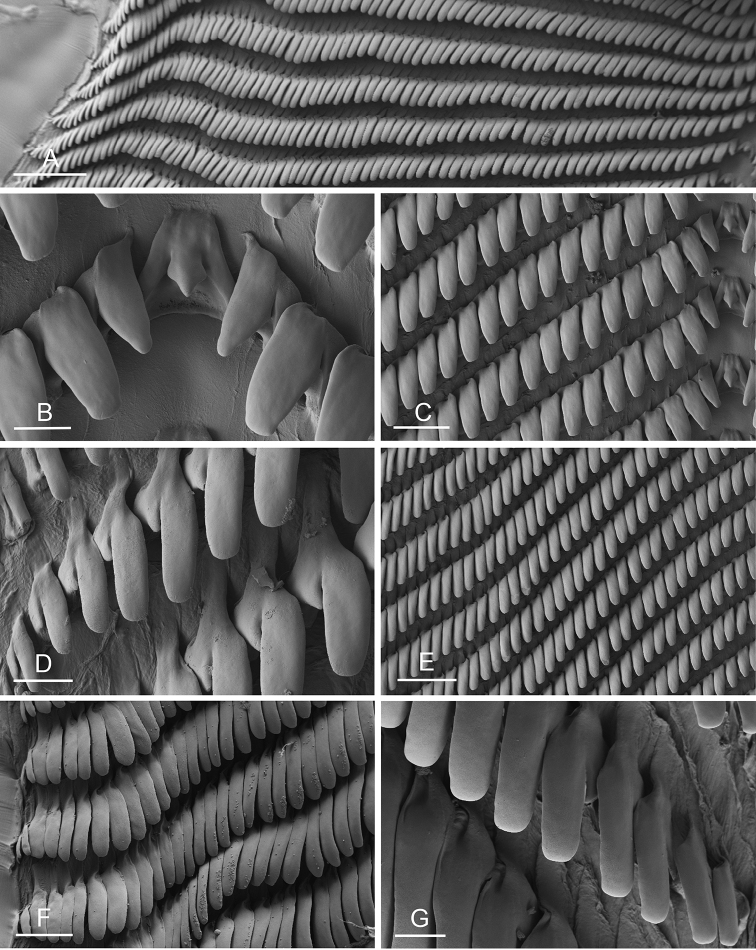
Radula, Peronia
willani, Australia, Northern Territory A holotype [1628 H] (NTM P.57625) B–E [1668] (NTM P.57627) F [1620] (NTM P.57626) G [1626] (NTM P.57627) A left half rows of teeth B rachidian and innermost lateral teeth C rachidian and innermost lateral teeth D outermost lateral teeth E lateral teeth F outermost lateral teeth G outermost lateral teeth. Scale bars: 200 μm (A), 20 μm (B, D, G), 60 μm (C, F), 100 μm (E).